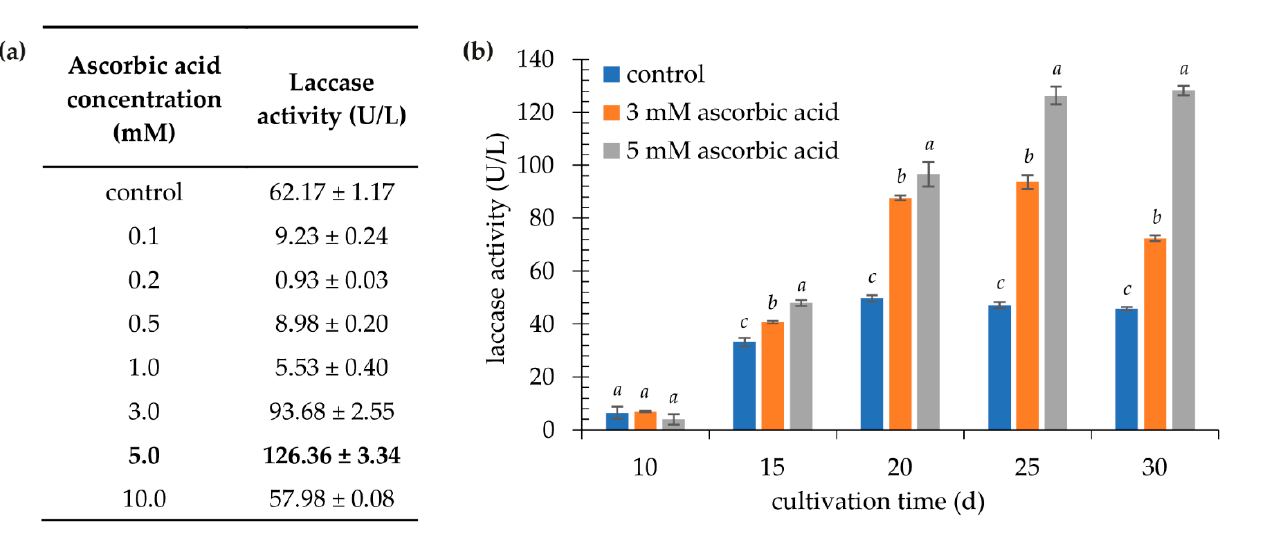
Figure 6. Influence of ascorbic acid on extracellular laccase activity. ( a ) Laccase activity after 25 days of cultivation with different concentration of ascorbic acid (the maximum activity with 5.0 mM of ascorbic acid is shown in bold); ( b ) laccase activity during cultivation in medium with 3 mM and 5 mM of ascorbic acid; the data presented as the means ± SD from at least three independent experiments; the means within single culture day that are marked with different letters ( a – c ) are significantly different.